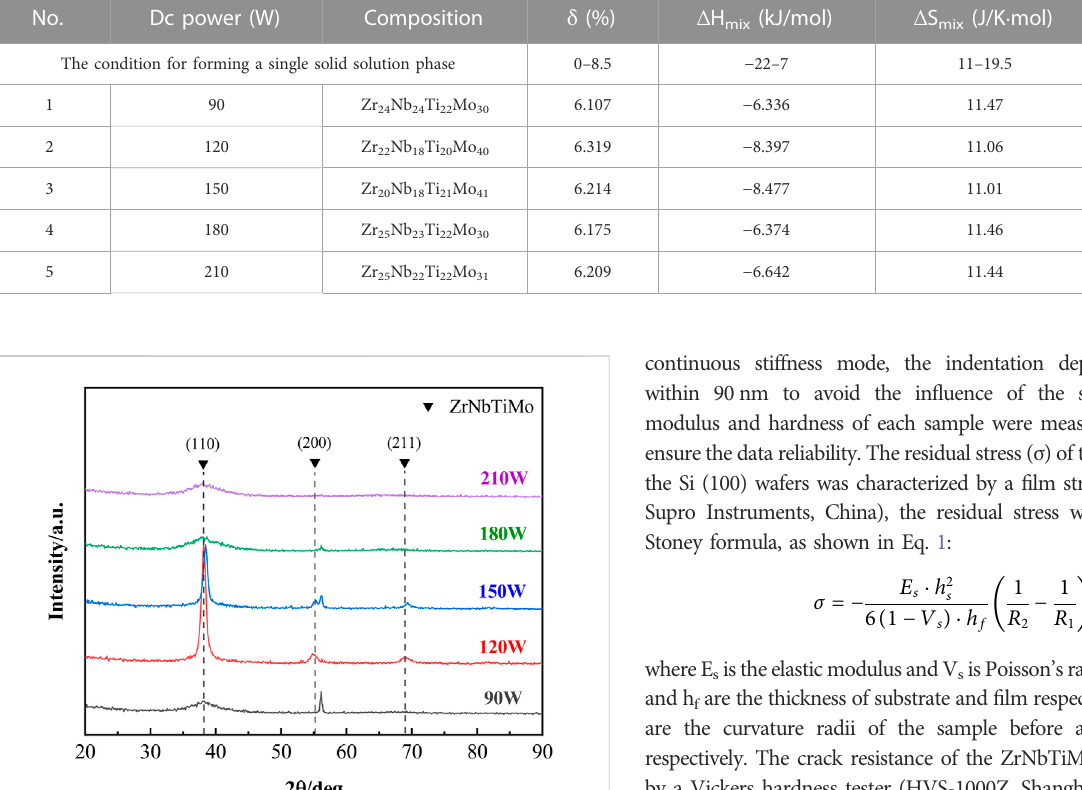
TABLE 1 The sputtering power, chemical composition, and thermodynamic parameters of the ZrNbTiMo RHEA fi lms. No.